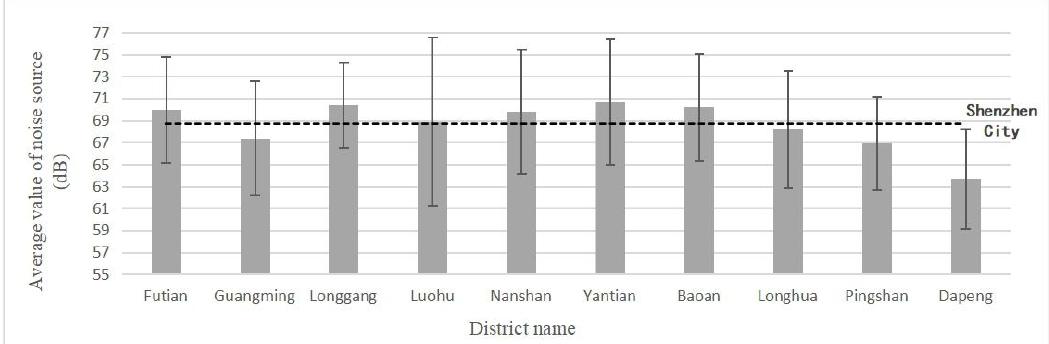
Figure 4. Current situation of traffic noise in Shenzhen and each district.